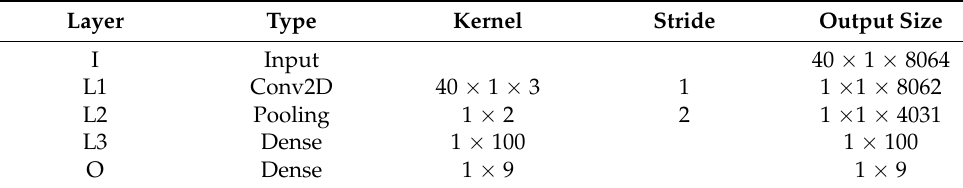
Table 1. Bottom-channel network structure diagram.